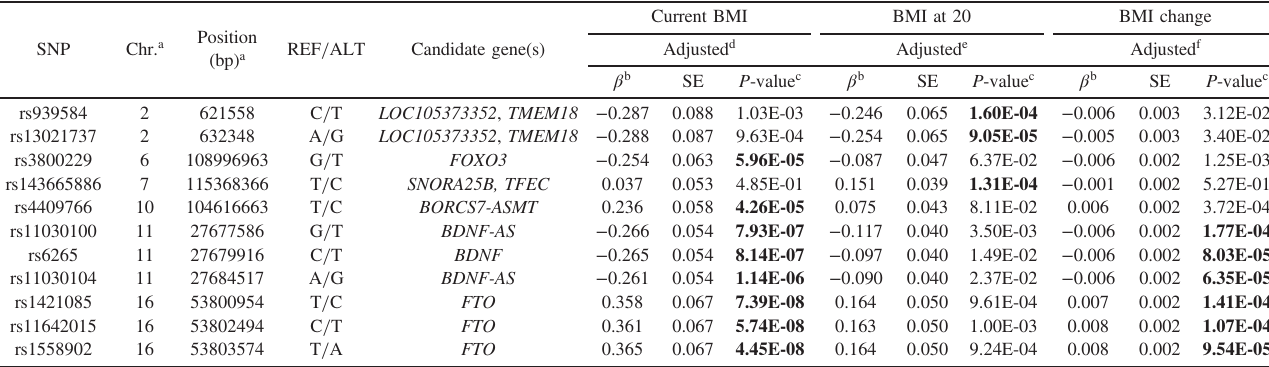
Figure 1. Manhattan plots of the association between candidate loci and each BMI phenotype in the adjusted model. The X-axis represents chromosomal position and the Y-axis represents % log 10 ( P -value). The grey solid horizontal line indicates signi fi cance level ( P = 1.77 ' 10 % 4 Table 3. Eleven identi fi ed SNPs associated with any of the BMI phenotypes in never-smokers